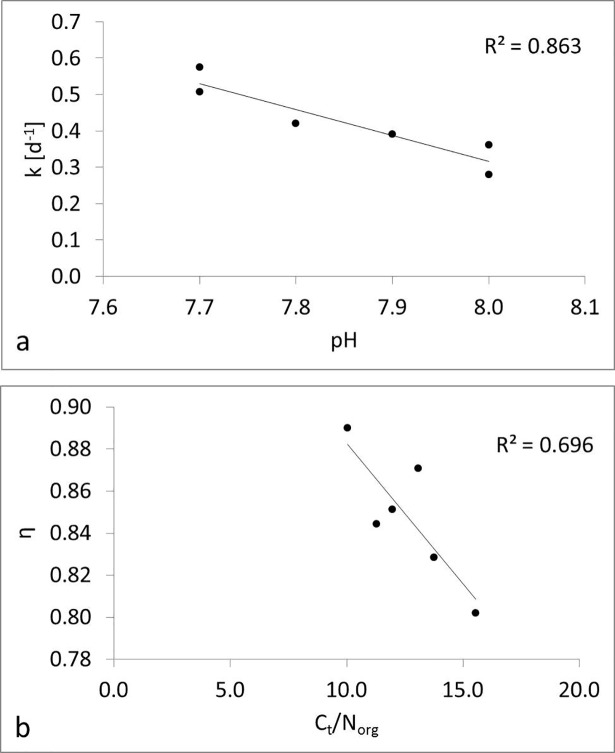
a) relationship and R2 of k and pH, b) relationship and R2 of η and Ct/Norg.